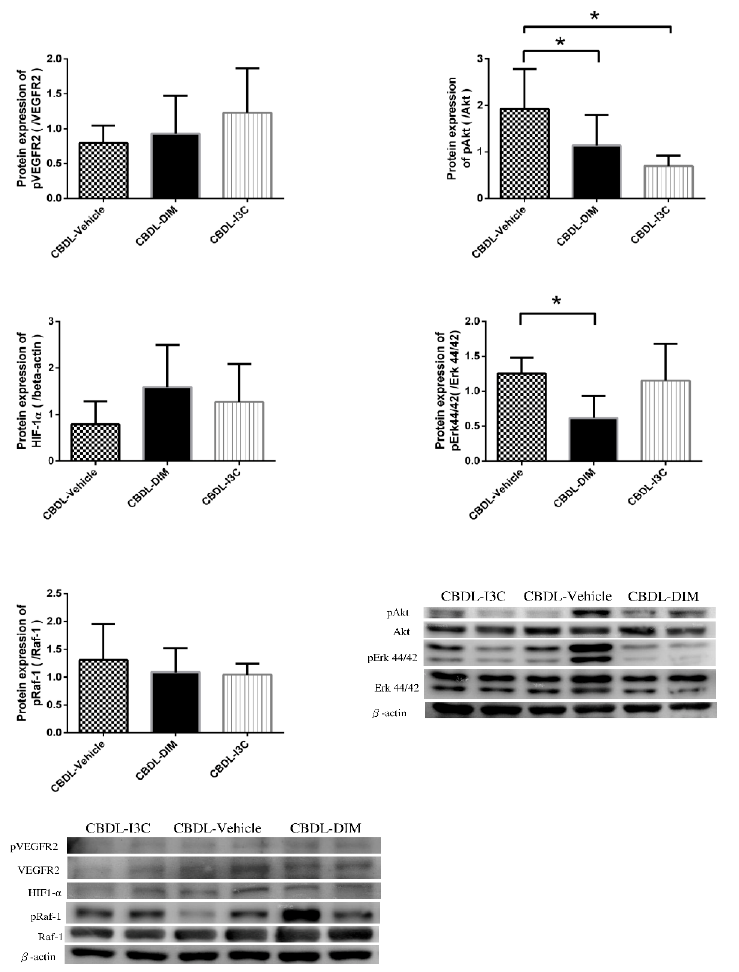
Figure 4. Mesenteric protein expressions of pVEGFR2 / VEGFR2, pAkt / Akt, HIF1- α , pErk44 / 42 / Erk44 / 42, pRaf-1 / Raf-1 in CBDL rats treated with vehicle, DIM, or I3C analyzed with ANOVA (* p < 0.05, DIM or I3C vs. vehicle). The representative images are shown below.